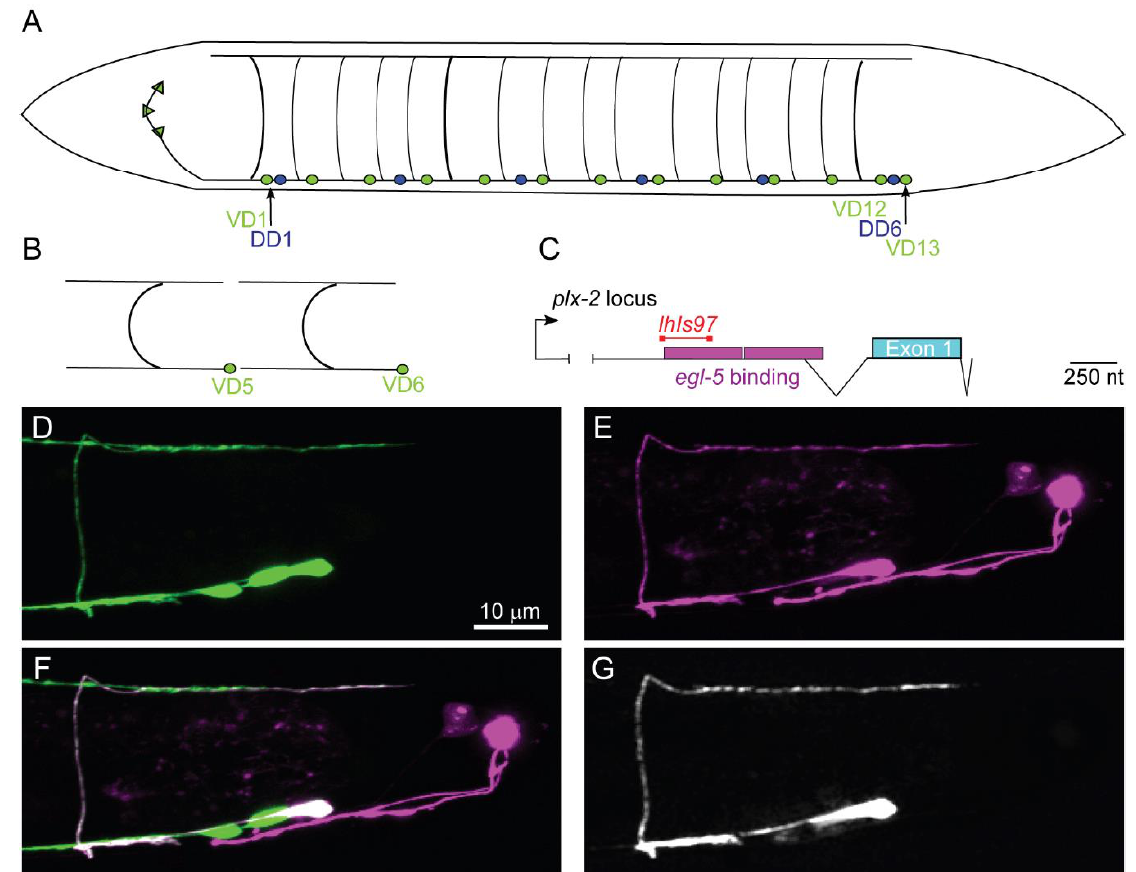
Figure 1. lhIs97 is a VD13-selective GABAergic motorneuron (MN) marker. ( A ) A schematic of the 19 GABAergic MNs. DD1 and VD1 are the most anterior and VD13 is the most posterior. ( B ) The characteristic tiled H shape of the VD neurons is illustrated. ( C ) A schematic of the plx-2 locus. The region upstream of the plx-2 first exon contains two egl-5 binding sites [28]. RNASeq experiments have identified an intron in the 5′ region (indicated by the branched line). The segment of the promoter used to generate the lhIs97 marker is indicated in red. ( D – G ) The posterior region of an lhIs97 wild-type animal showing GABAergic GFP ( D ), lhIs97- expressed RFP ( E ), the merge of the two channels ( F ) and the overlap of the GFP and RFP channels, which is exclusive to VD13 ( G ).